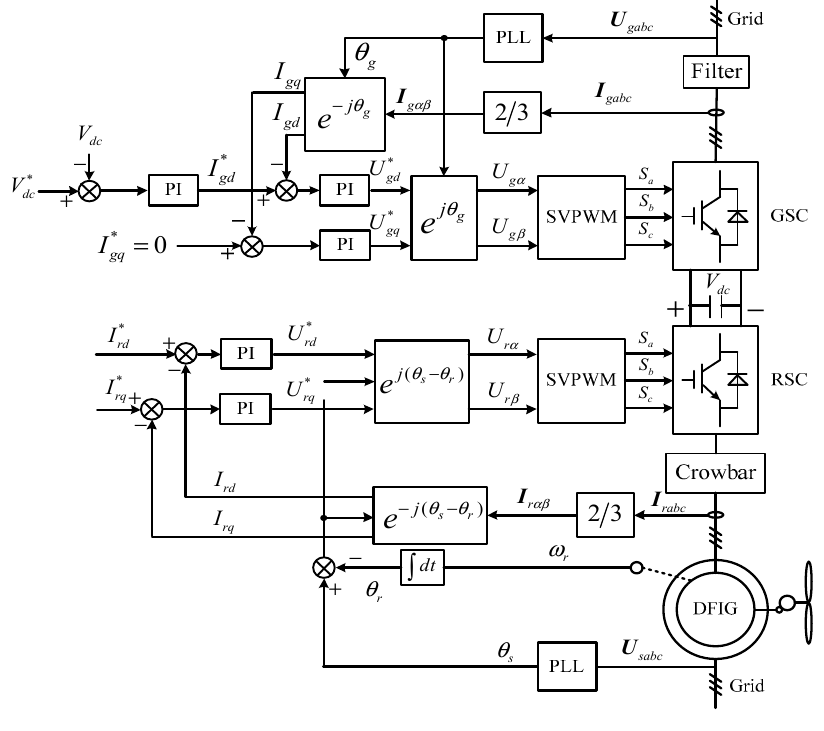
Figure 1. Control diagram of DFIG system.